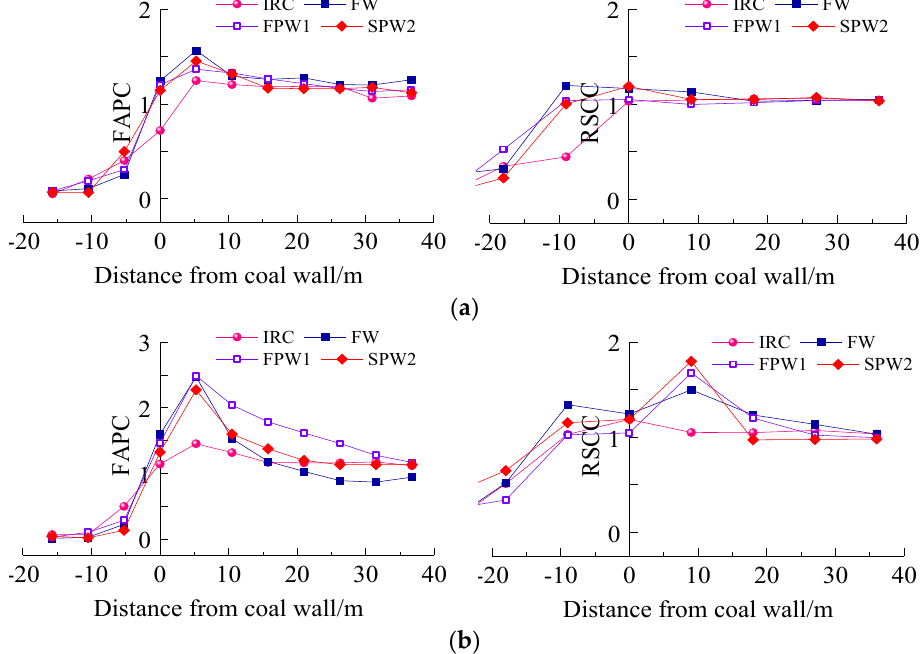
Figure 11. Law of FAPC and 24 m layer RSCC: ( a ) FAPC and 24 m layer RSCC of interburden unbroken. ( b ) FAPC and 24 m layer RSCC of interburden broken.